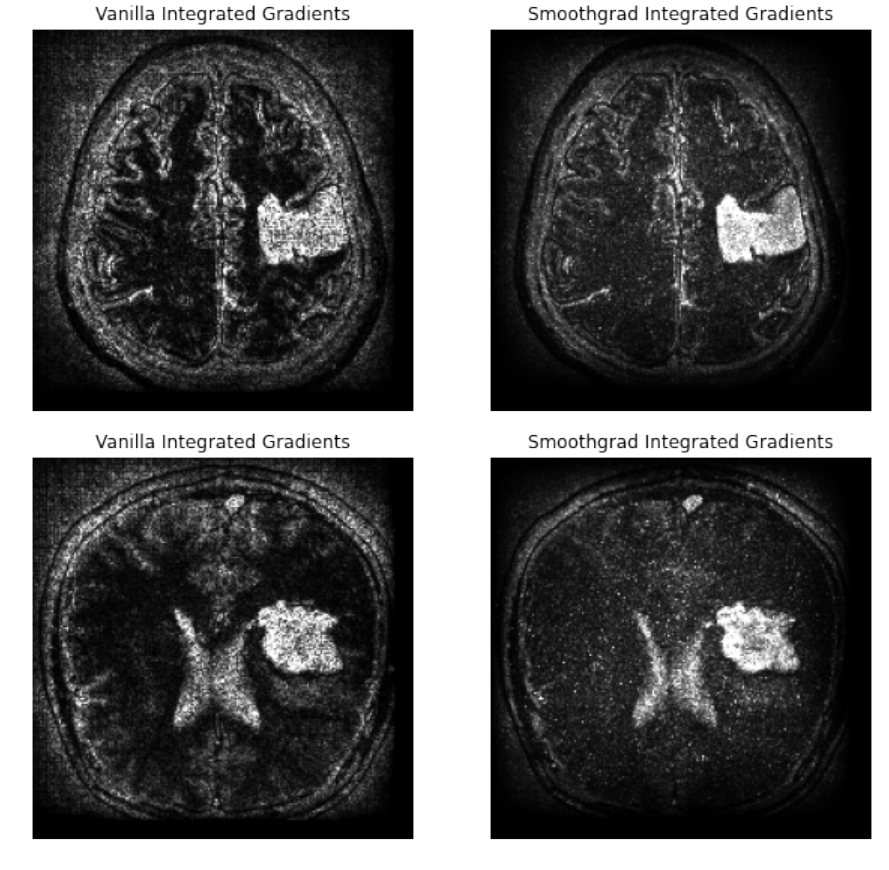
Figure 11. Vanilla IG